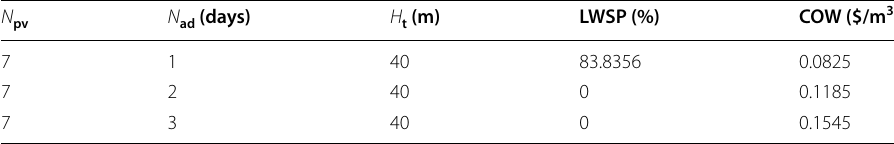
Table 8 Influence of reservoir water storage size on the cost and reliability of the system N pv N ad (days)